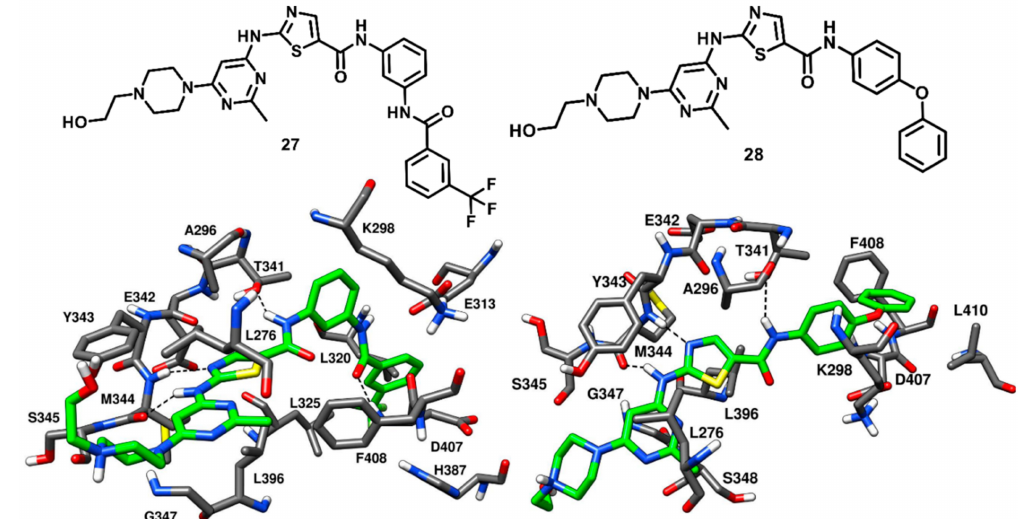
Figure 22. 2D structures of 27 and 28 . X-ray structures of c-Src kinase in complex with 27 (PDB ID: 4YBJ) and 28 (PDB ID: 4YBK). Active site residues of c-Src kinase and the enzyme–inhibitor H-bond interactions are